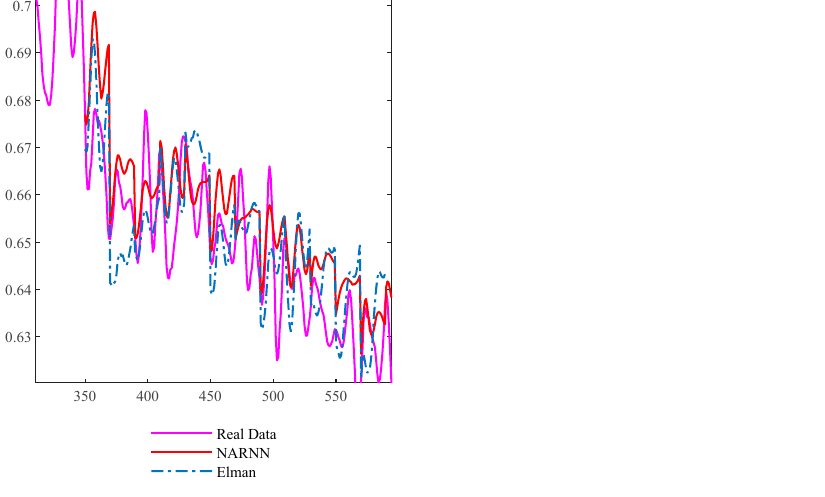
Figure 10. Twenty ‐ step ‐ ahead prediction of M5, M6 without any decomposition algorithm. Figure 10. Twenty-step-ahead prediction of M5, M6 without any decomposition algorithm. Table 2. Multistep prediction error analysis (RMSE).